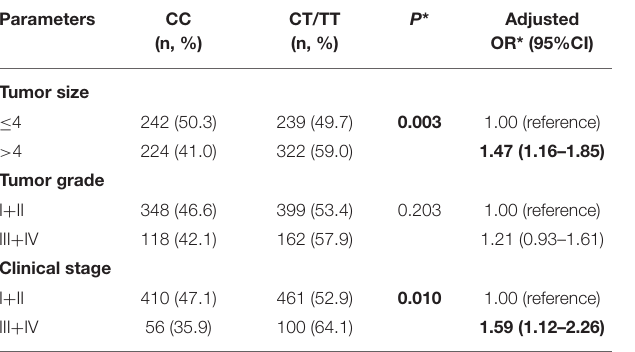
TABLE 2 | Associations of lncRNA H19 rs2839698 polymorphism with clinicopathological characteristics of RCC. Parameters